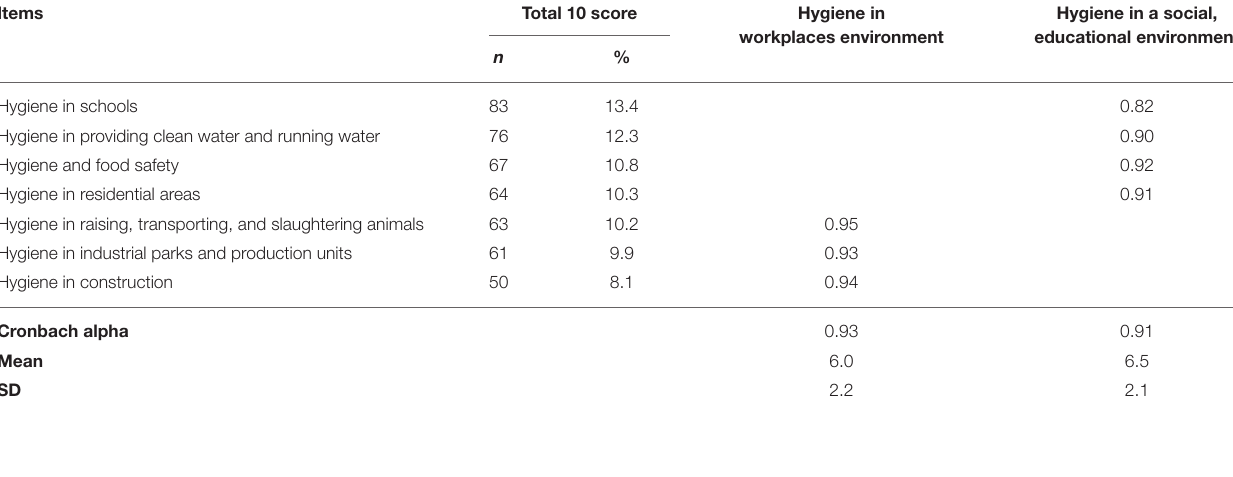
TABLE 2 | Local hygiene practices (Band score